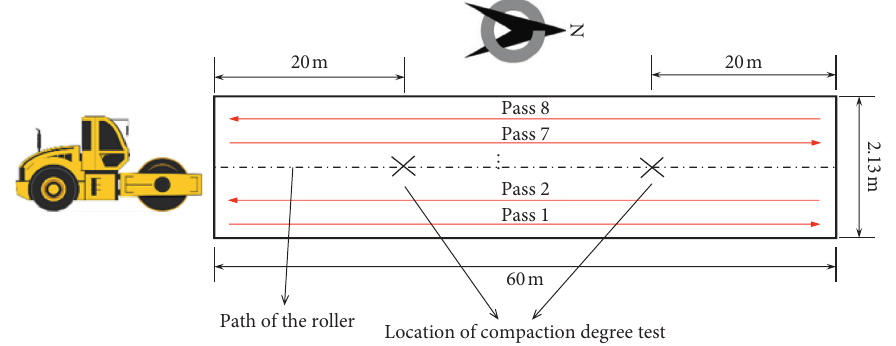
Figure 2: Test lane.